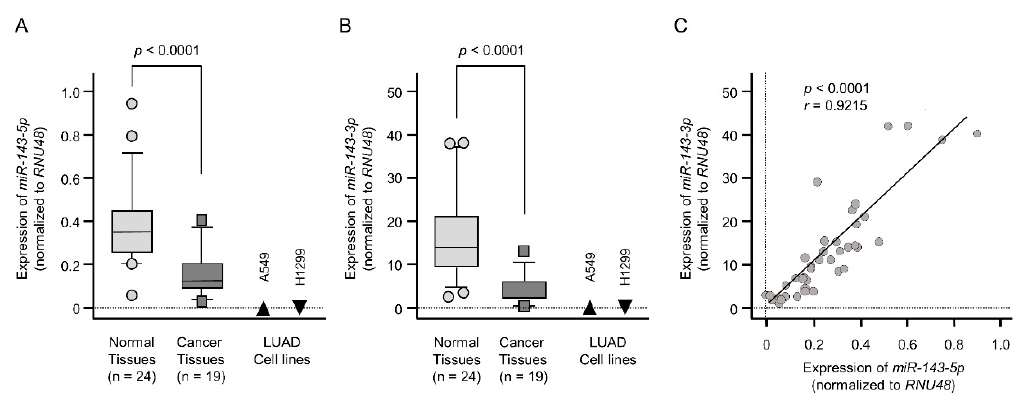
Figure 1. Expression of miR-143-5p and miR-143-3p in LUAD clinical specimens and cell lines. ( A ) Downregulation of miR-143-5p was detected in LUAD specimens and cell lines (A549 and H1299 cells). Data were normalized according to the expression of RNU48 (internal control). ( B ) Downregulation of miR-143-3p was detected in clinical specimens and cell lines. ( C ) miR-143-5p and miR-143-3p expression levels were positively correlated in clinical specimens, as demonstrated by Spearman’s rank tests. Table 1. Characteristics of patients with LUAD and noncancerous controls.